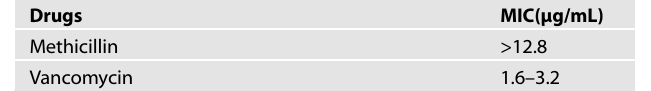
Table 1. MICs of drugs in